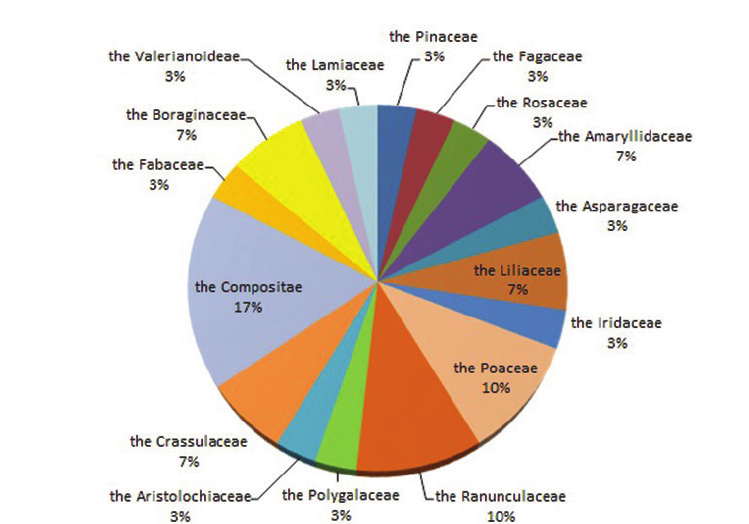
Figure 5. Floristic content of rare species in the Republic of